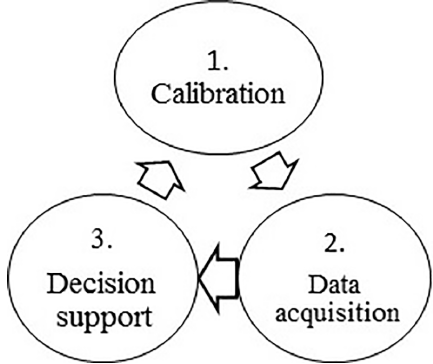
Figure 4. Steps of measurement